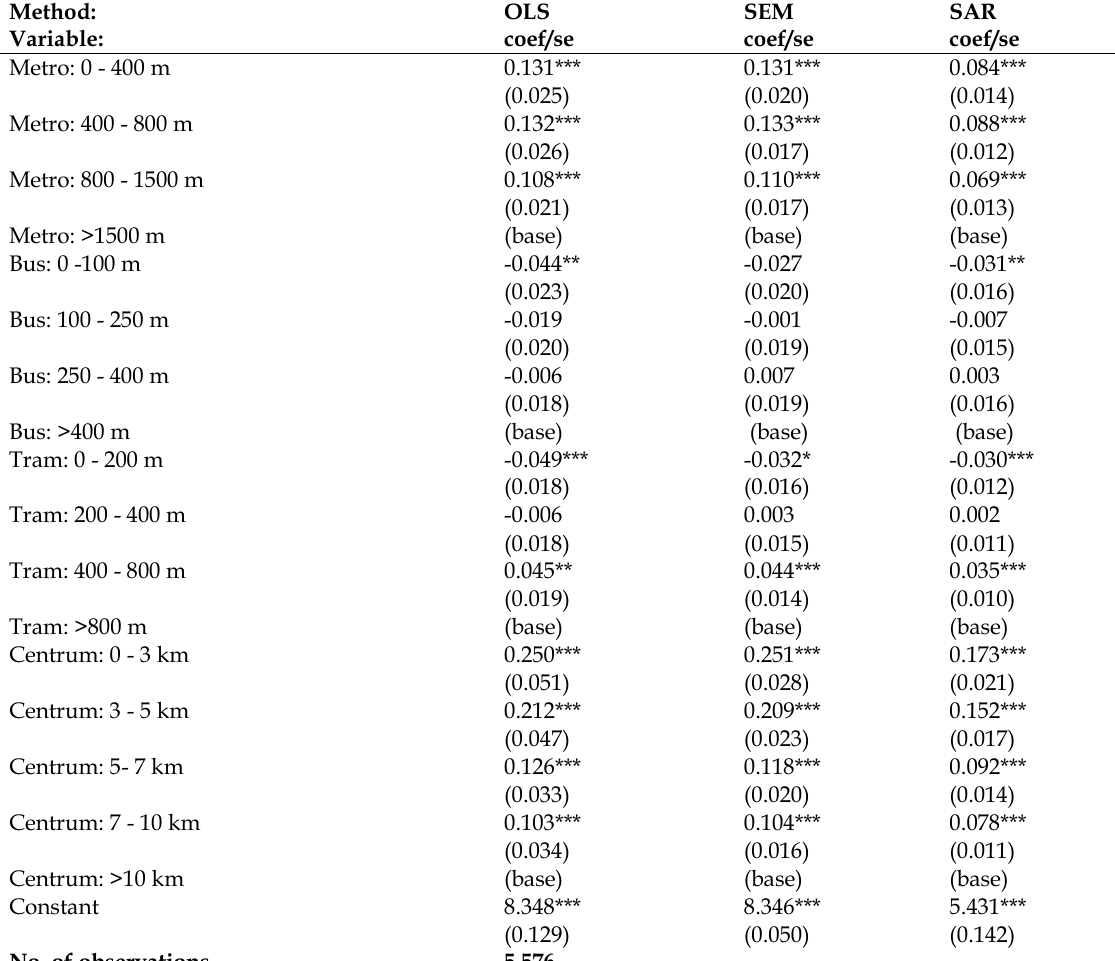
Table 4. Estimation results using OLS, SEM and SAR methods